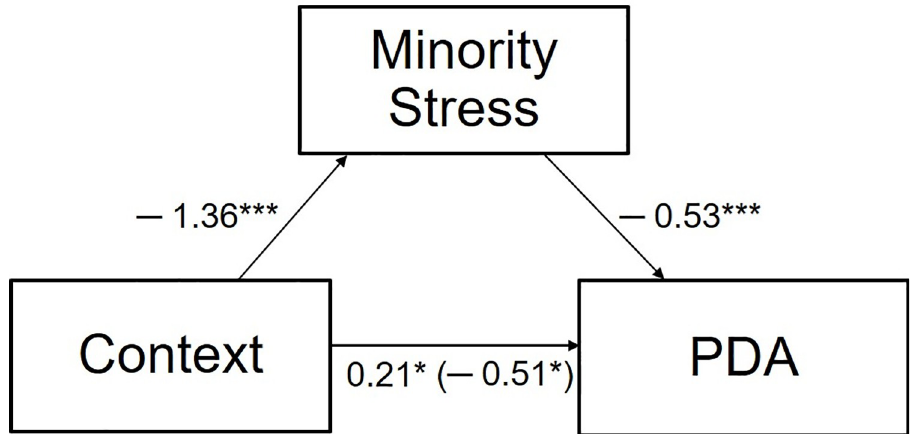
Fig 7. A within-participants mediation analysis in which minority stress mediates the effect of context on PDA. Context is coded 0 = campus and 1 = city. � p < .05. ��� p < .001.